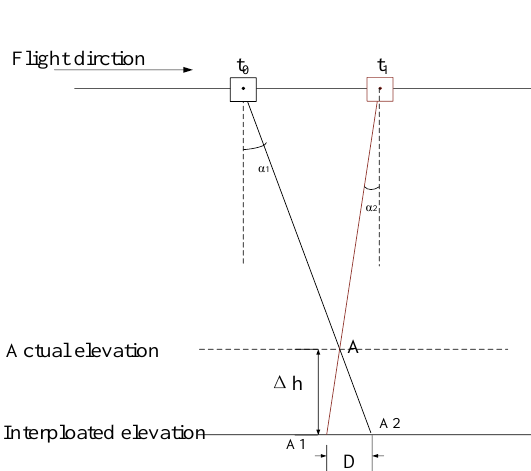
Figure 14. Influence of the elevation error.